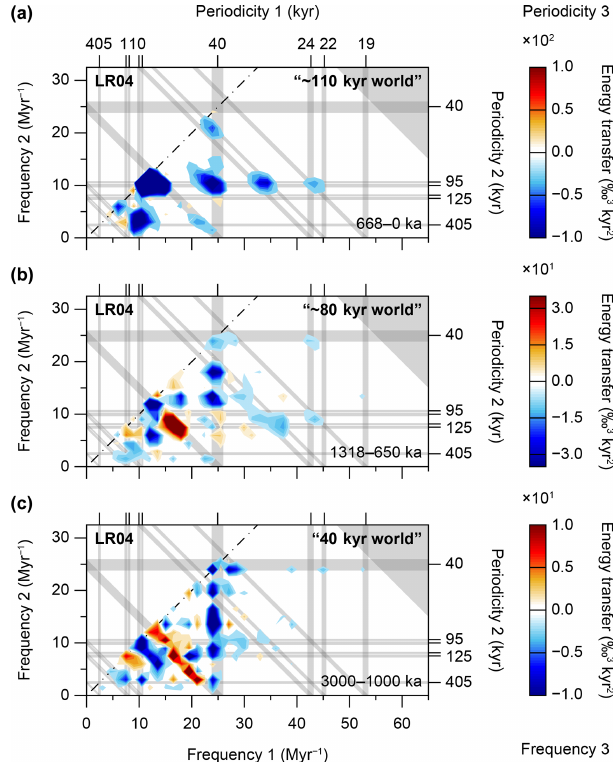
Figure 4. Bispectra of Pliocene and Pleistocene climate cycles. (a) Imaginary part of a bispectrum of the Middle and Late Pleis- tocene “ ∼ 110kyr world”. Age range = 668 to 0ka. Resampling resolution = 1kyr − 1 . Window length = 668kyr. Block length = 668kyr. Number of blocks = 1. Number of merged frequencies =